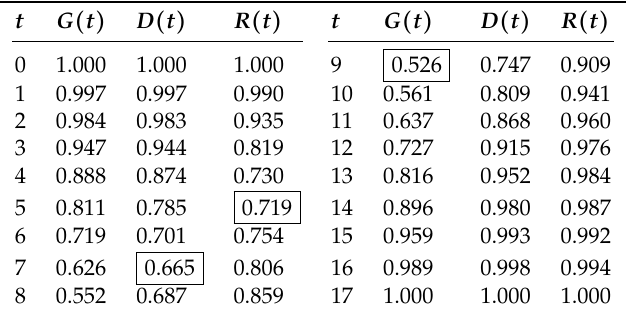
Table 10. Transitivity numbers for the threshold graphs. The minimum values are boxed. t G ( t